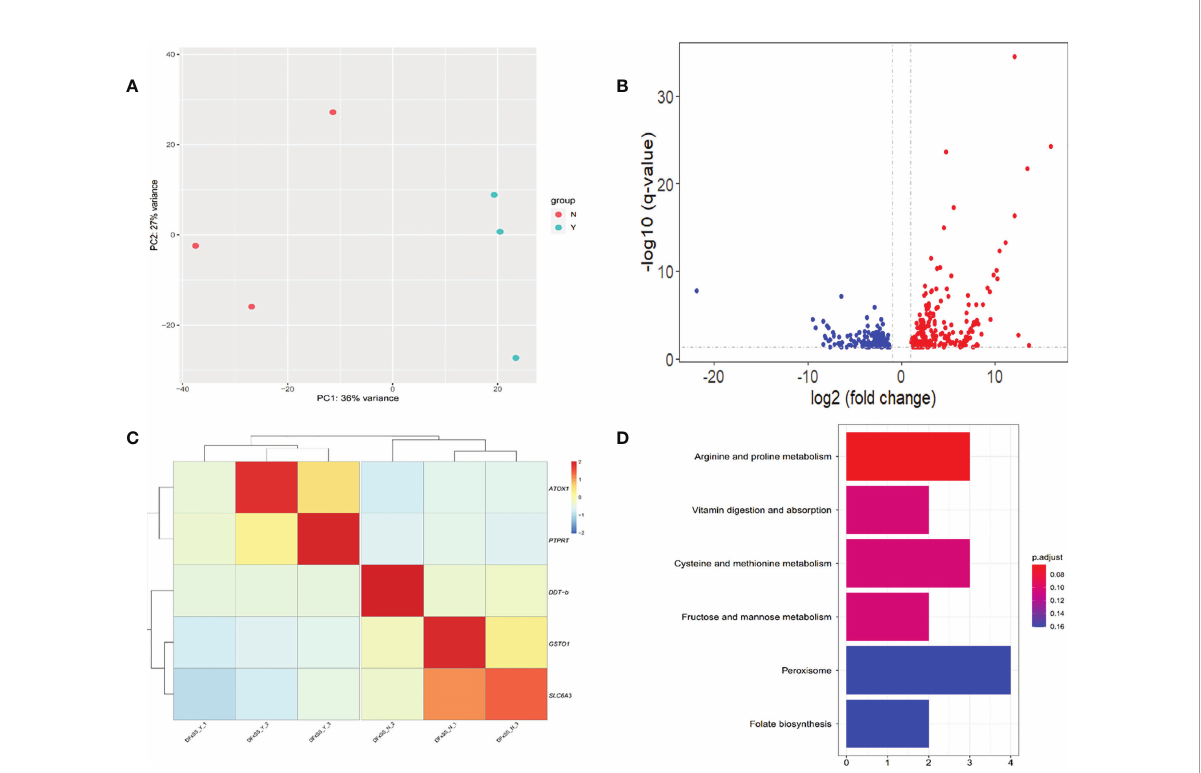
FIGURE 5 Transcriptomic analysis between individuals with black mantle markings (Y group) and individuals without black mantle markings (N group). (A) Principal component analysis plot based on the whole-genome gene expression pro fi les. (B) Volcano plot of gene expression in the mantle of Y group and N group. The up-regulated and down-regulated differentially expressed genes (DEGs) are shown in red and blue dots, respectively. (C) Heatmaps of candidate DEGs. (D) KEGG enrichment pathways of the